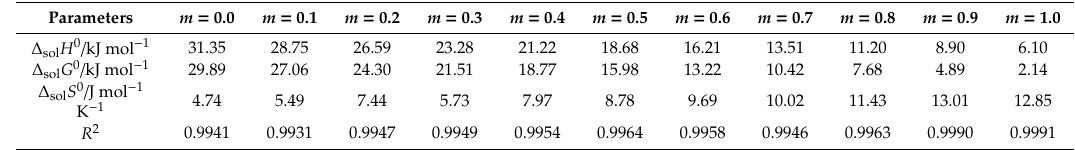
Table 3. Apparent thermodynamic quantities ( ∆ sol H 0 , ∆ sol G 0 and ∆ sol S 0 ) and R 2 values for PPD dissolution in binary DMSO + water mixtures b